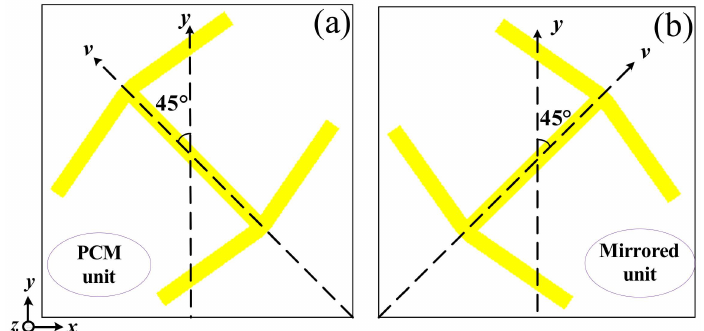
Figure 6. Schematic of x -to- y polarization conversion for ( a ) the PCM unit, and ( b ) mirrored unit.